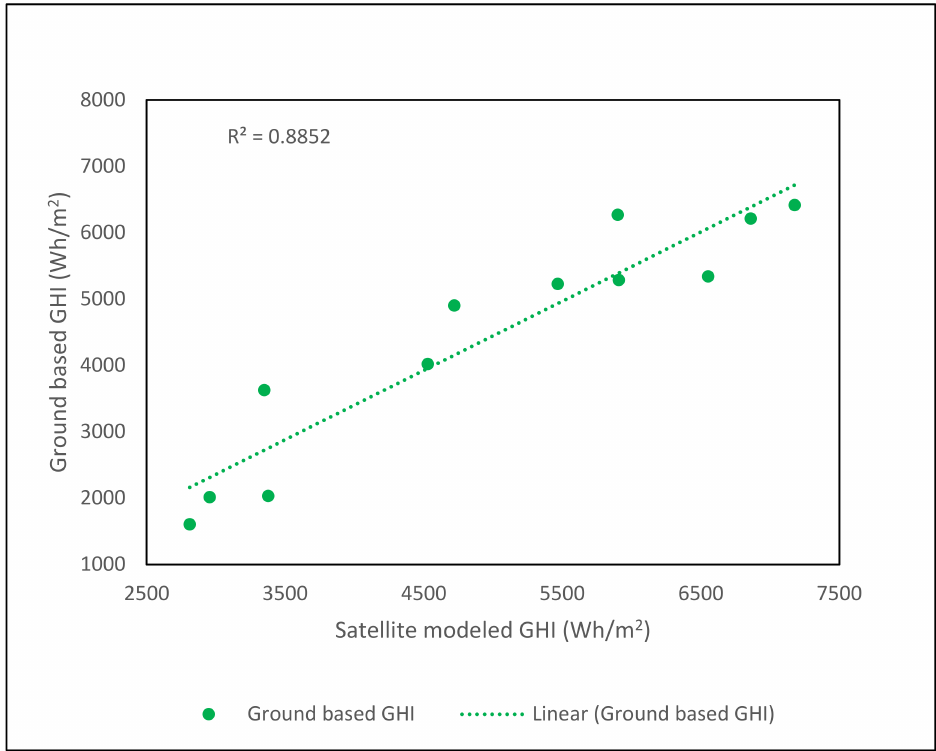
Figure 6. Correlation of satellite modeled GHI with ground-based